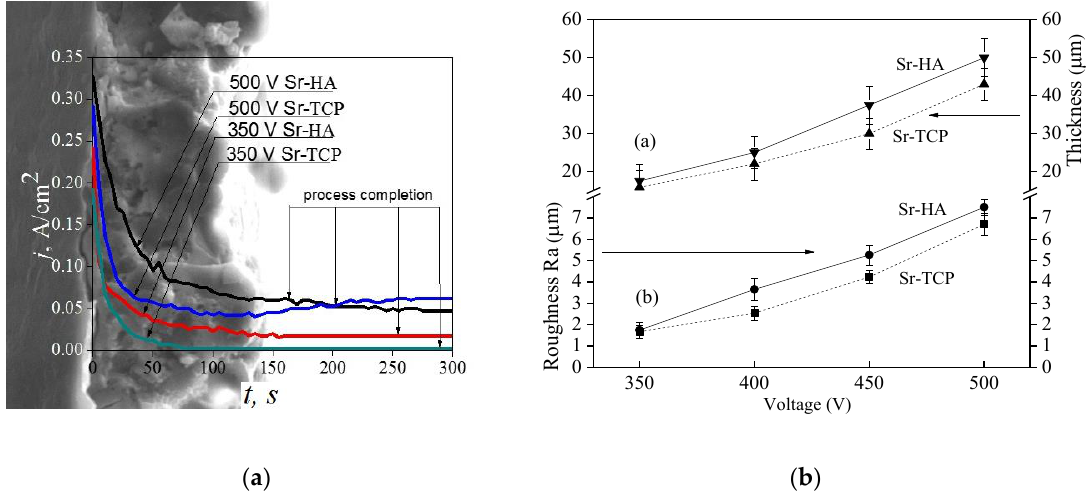
Figure 1. The graphs of the current density versus the process duration for deposition of the Sr-substituted hydroxyapatite (Sr-HA) and Sr-substituted tricalcium phosphate (Sr-TCP) coatings on Mg0.8Ca ( a ) and the graphs of the coatings thickness and roughness Ra versus the applied voltage ( b ).